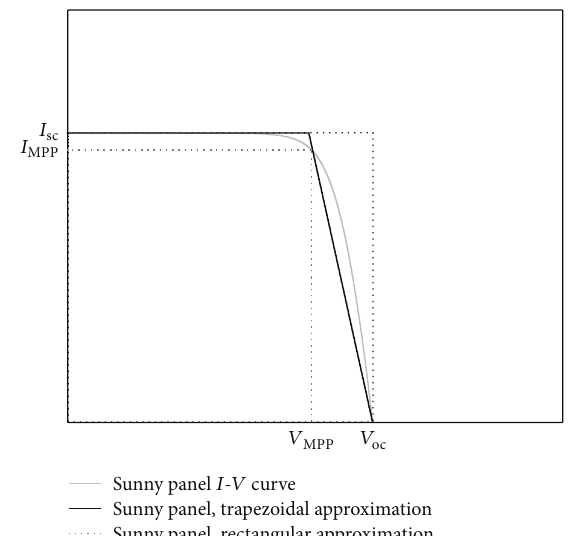
Figure 1: Current-voltage characteristic of a PV panel (solid grey line) compared to both rectangular (dotted black line) and trapezoidal (solid black line) approximation. 𝑉 of the panel are also